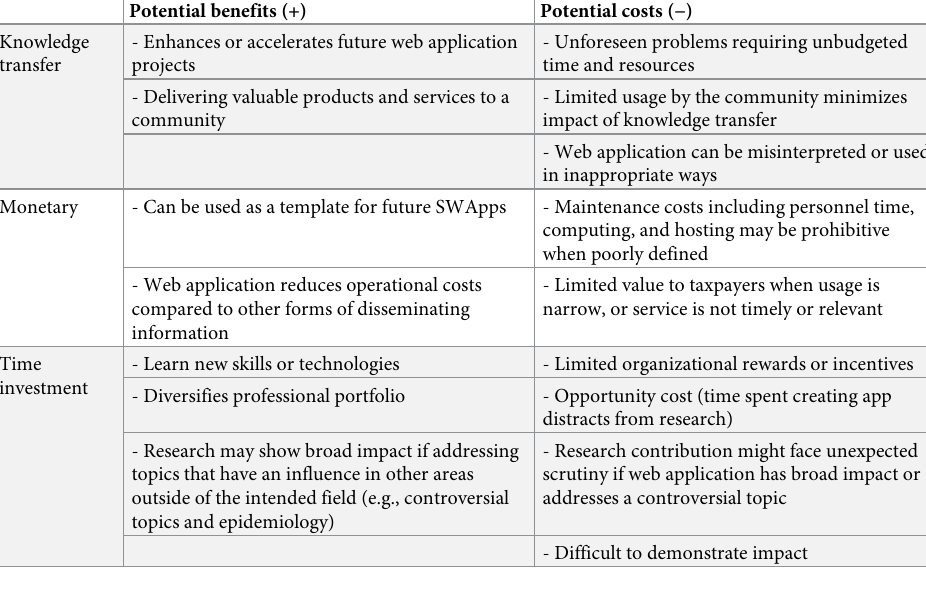
Table 1. Potential costs and benefits for researchers to consider when creating, participating in, or leading a SWApp project.